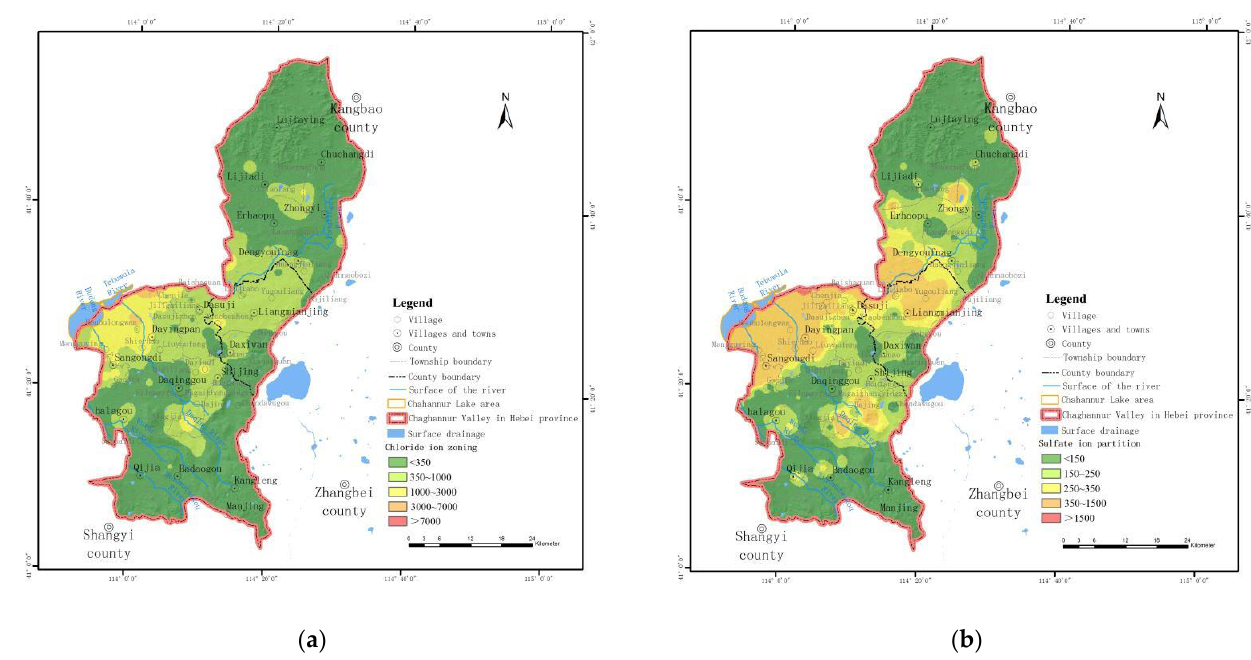
Figure 7. Spatial distributions of ( a ) Cl− and ( b ) SO 4 2− in the Chahannur Basin.